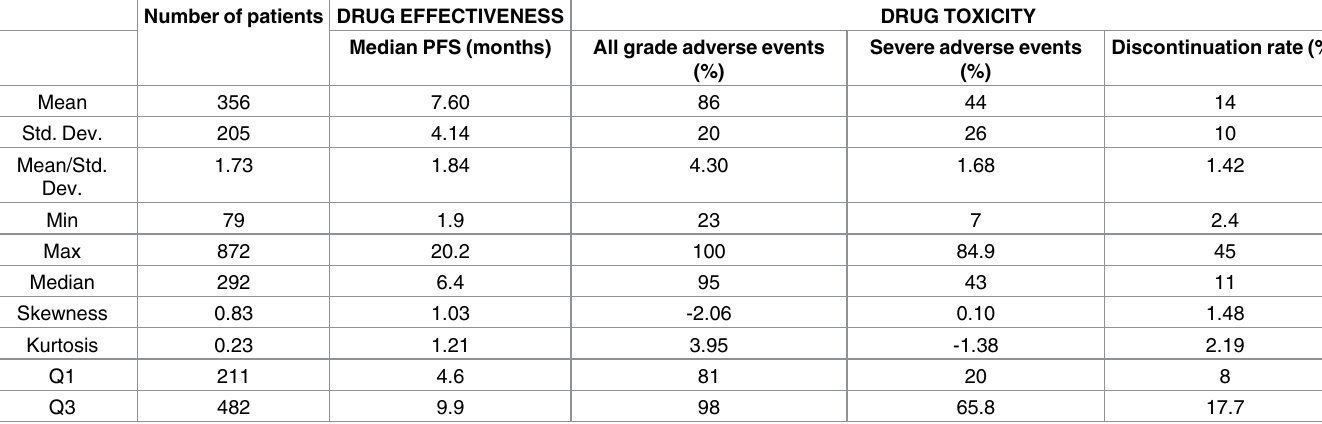
Table 2. Main statistical indicators of the dataset. Number of patients DRUG